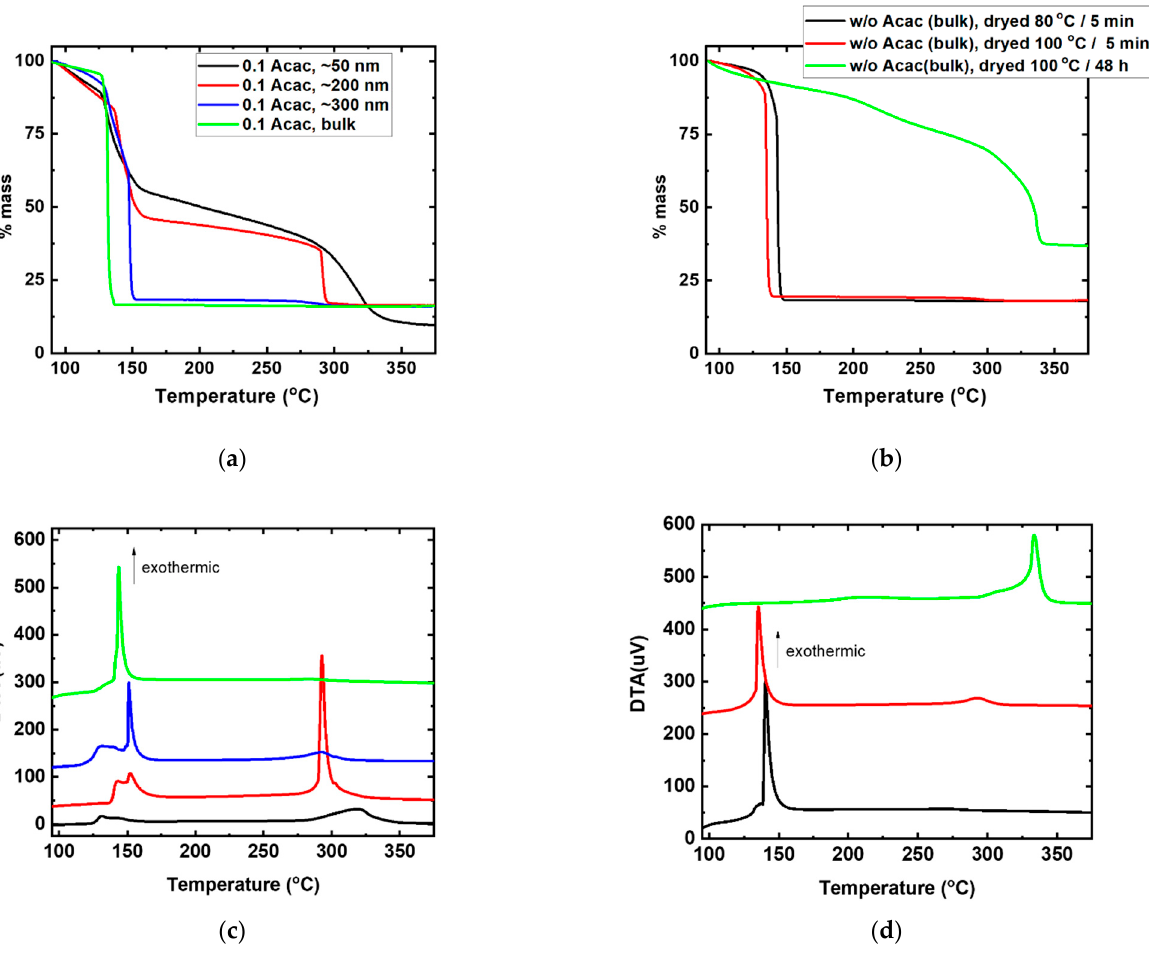
Figure 3. ( a ) TGA curves of different thickness (50, 200, 300 nm and bulk) films containing 0.1 molar ratio of fuel (Acac) to oxidizer (Cu, Ni nitrates) in 2 ‐ methoxy ethanol and ( b ) TGA curves of combustion ‐ synthesized bulk samples prepared from precursor with Cu and Ni nitrates but without (w/o) Acac and 2 ‐ methoxy ethanol as solvent dried at 80 °C and 100 °C for 5 min and at 100 °C for 48 h. The respective DTA curves for ( c ) different thickness (50, 200, 300 nm and bulk) and ( d ) bulk samples.